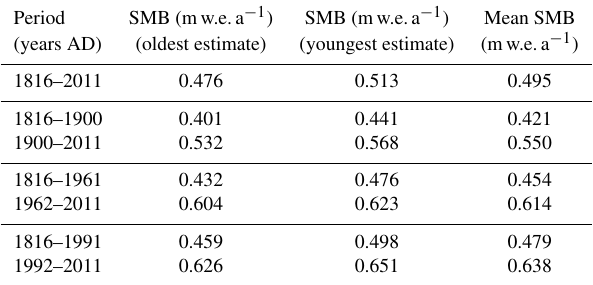
Table 1. Mean SMB at IC12 for different time periods. These values may be compared with those of several published studies, summa- rized in Table S1.